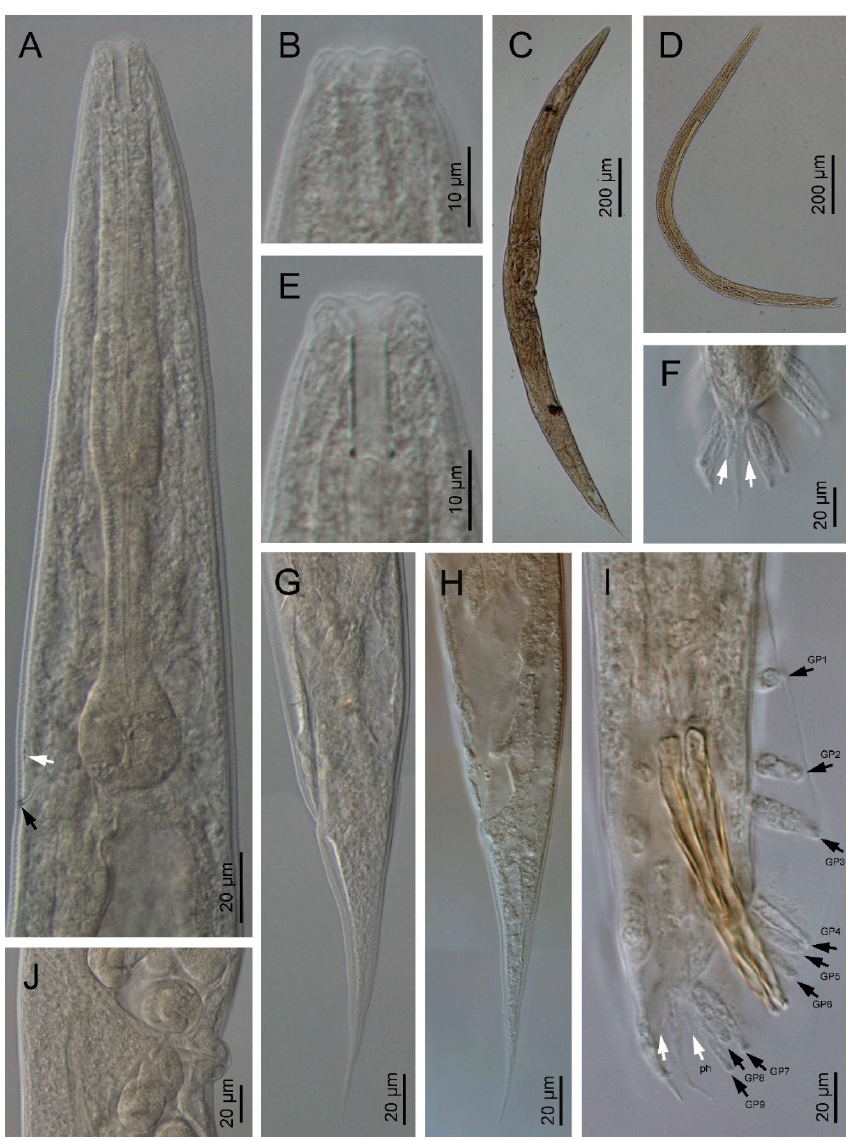
Figure 2. Oscheius siddiqii Tabassum and Shahina, 2010 (light microscopy). ( A ): Neck (black arrow pointing the excretory pore and white arrow pointing the hemizonid); ( B , E ): anterior end; ( C ): entire female; ( D ): entire male; ( F ): male tail end (arrows pointing phasmids); ( G , H ): female posterior end (arrow pointing the phasmid); ( I ): male posterior end (black arrows pointing genital papillae (GP), white arrows pointing phasmids (ph)); ( J ): female vulva.